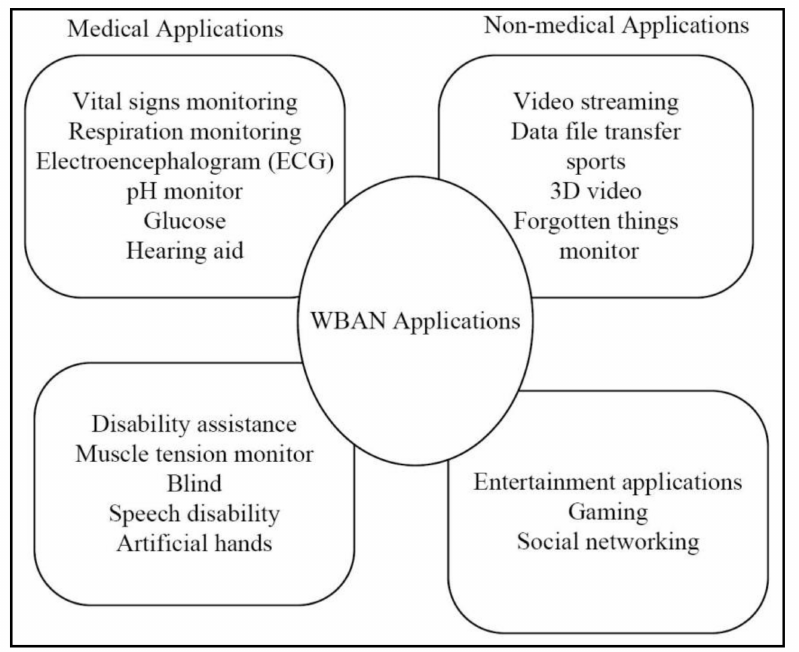
Figure 1. IEEE 802.15.6 standard-based body sensor networks applications.